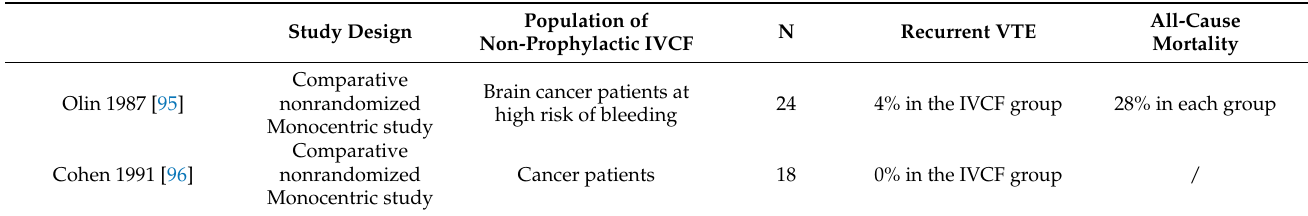
Table 3. Incidence of death rate and recurrent VTE post-IVCF